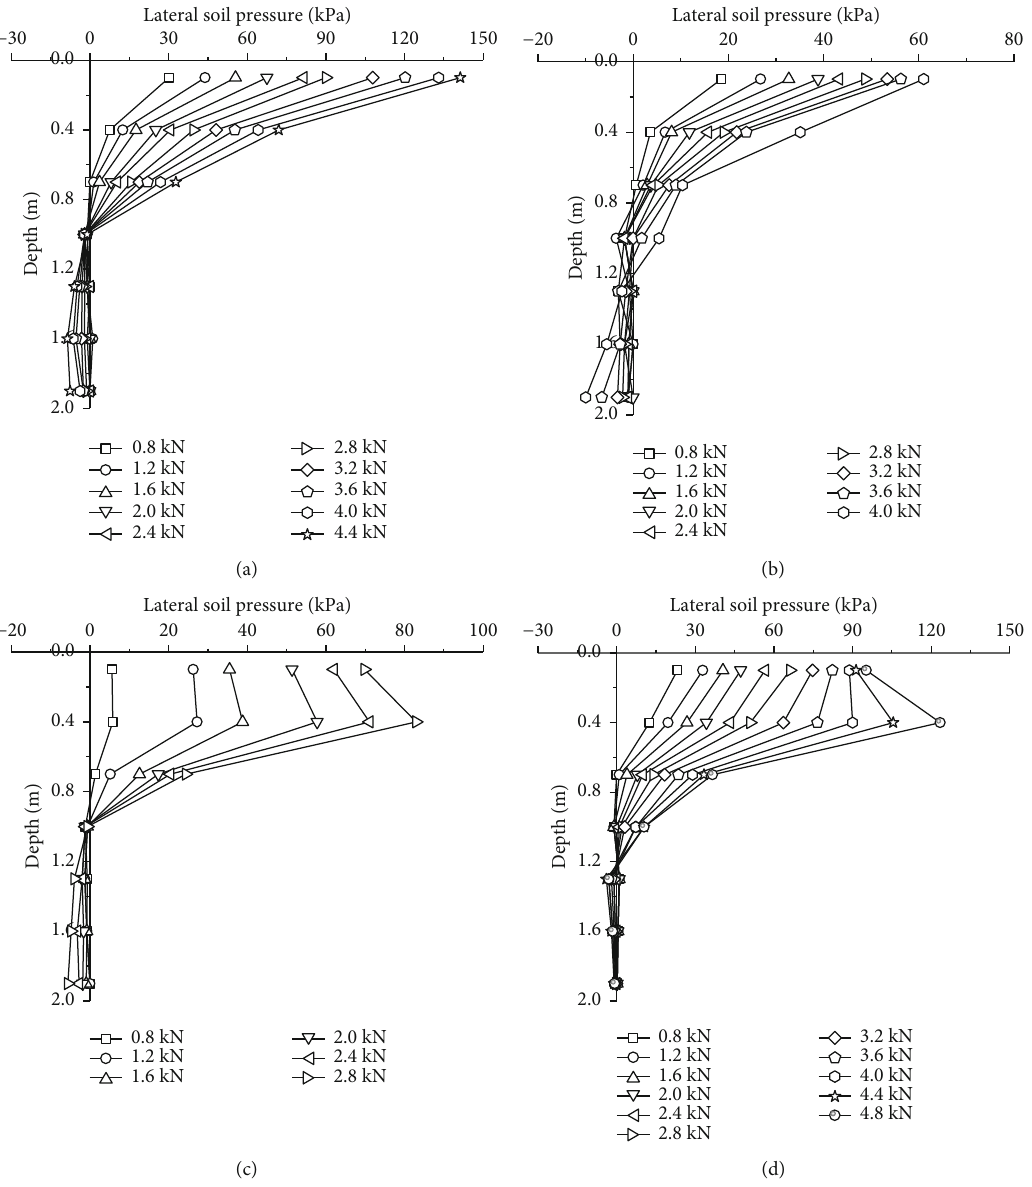
pile; (b) Y pile; (c) C pile; (d) C 1 2 1 2